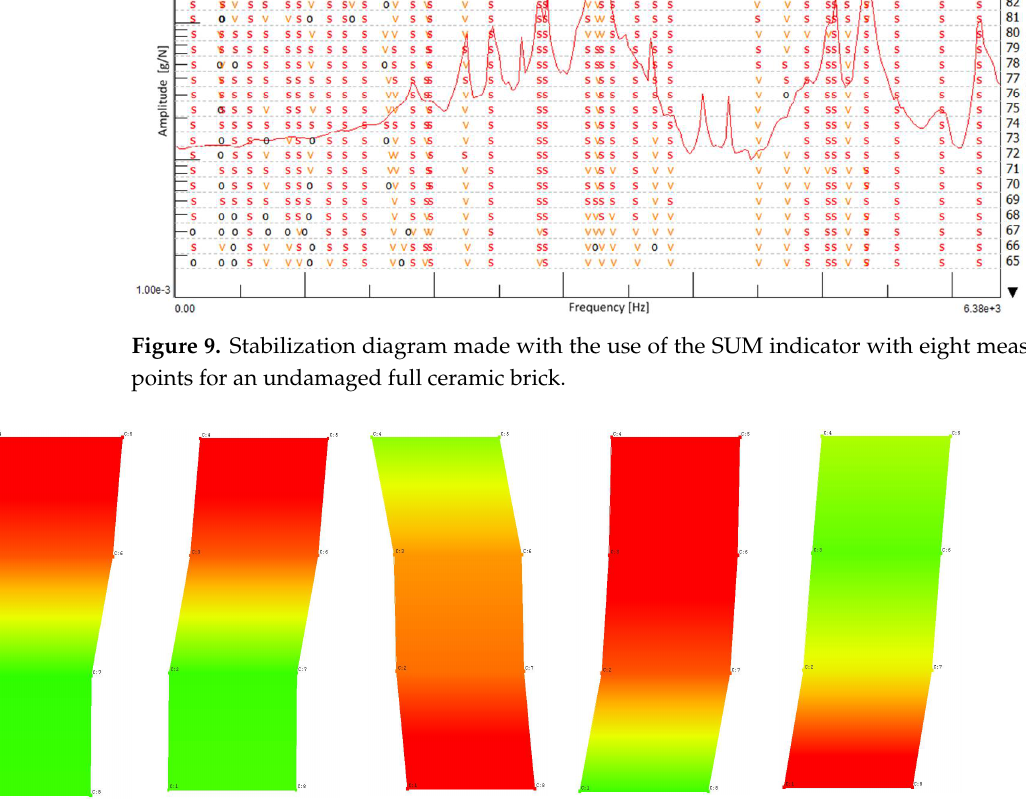
Figure 9. Stabilization diagram made with the use of the SUM indicator with eight measurement points for an undamaged full ceramic brick.